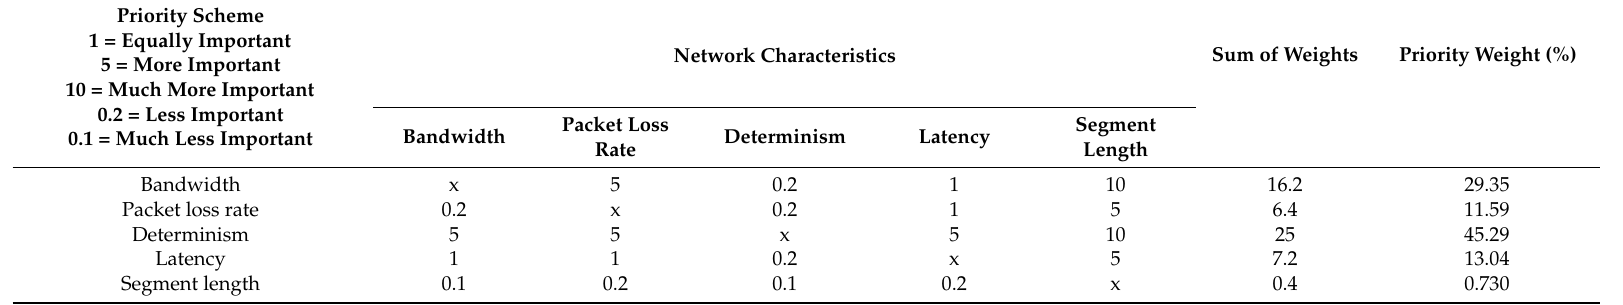
Table 13. Priority analysis matrix including example network characteristics.